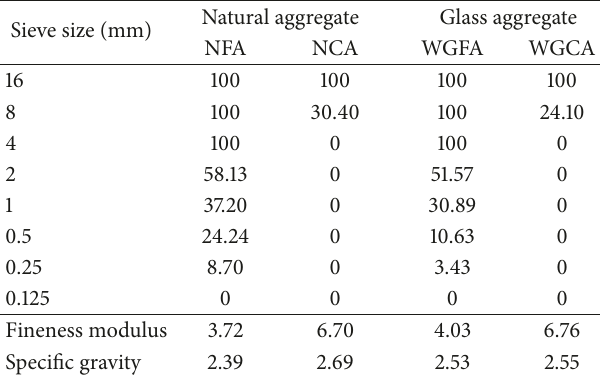
Table 2: Physical properties of natural and glass